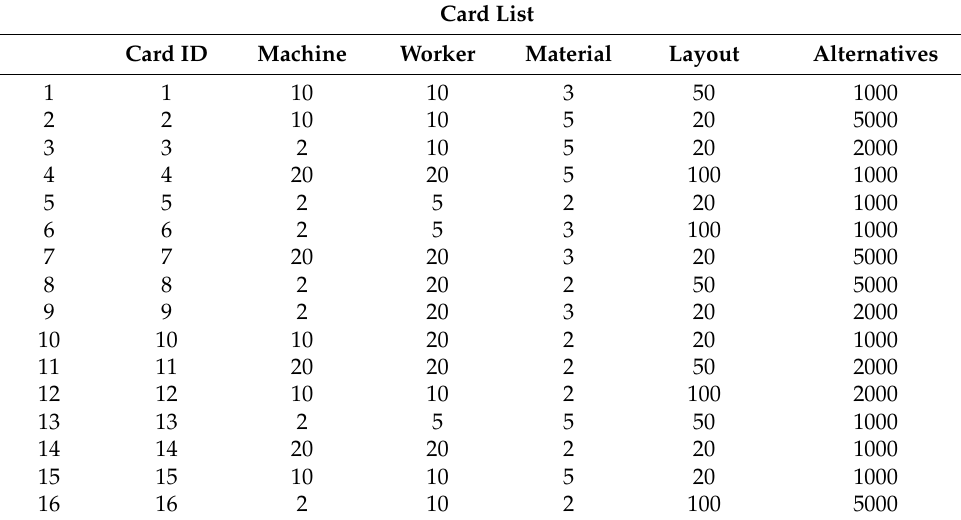
Table 9. Plan cards that are designed by orthogonal design using SPSS.